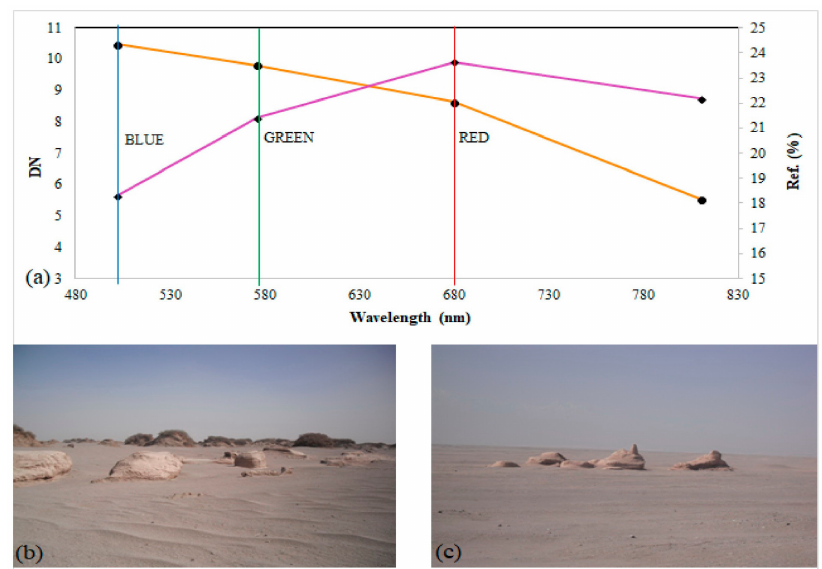
Figure 5. The spectral profiles of LATTICs before (orange DN values) and after (purple reflectance values) atmospheric correction using FLAASH ( a ); and the canals have high optical reflectance values due to being buried under gravel and sand deposits ( b , c ).